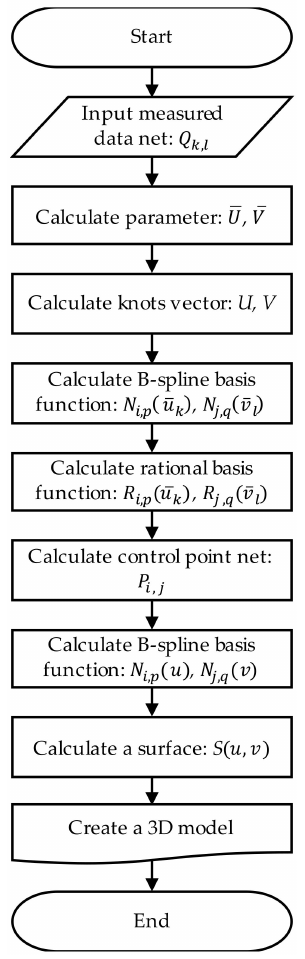
Figure 1. Flow chart of Non-Uniform Rational B-Spline (NURBS) surface interpolation.